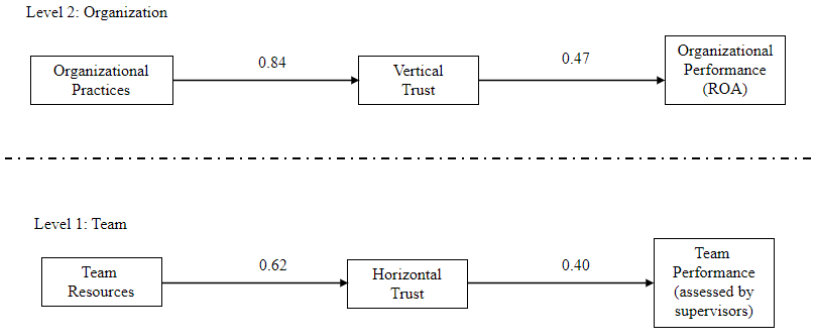
Figure 2. Final Model: Multilevel analyses (N = 890 employees nested in N level 2—31 companies; N level 1—177 teams with employees and their immediate